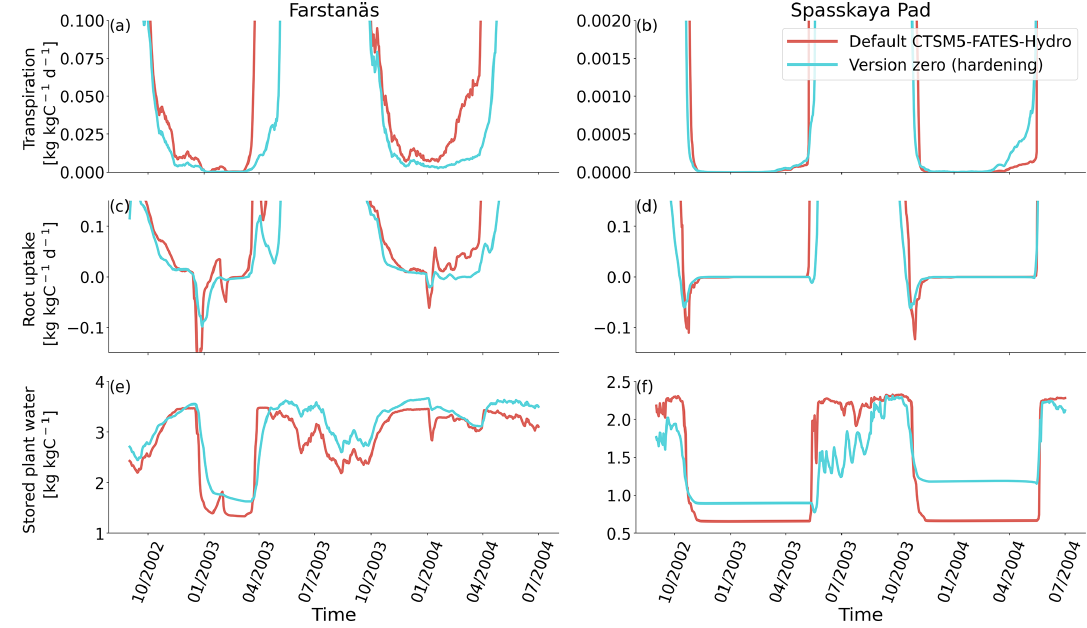
Figure 6. Plant water fluxes for needleleaf evergreen trees at the sites of ( a , c , and e ) Farstanäs and ( b , d , and f ) Spasskaya Pad during the period September 2002–July 2004. (a,b) Transpiration, (c,d) root water uptake, and (e,f) stored plant water. The default simulation is shown in red, and the hardening simulation is shown in